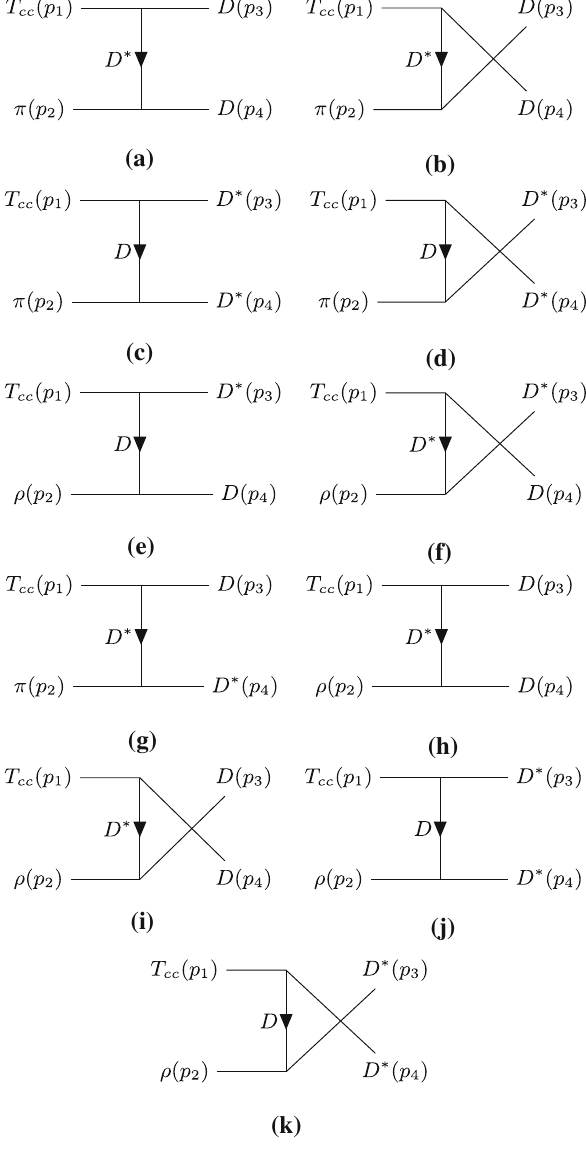
D ( ∗ ) = ( D ( ∗ ) 0 , D ( ∗ ) + ) represents the isospin doublet